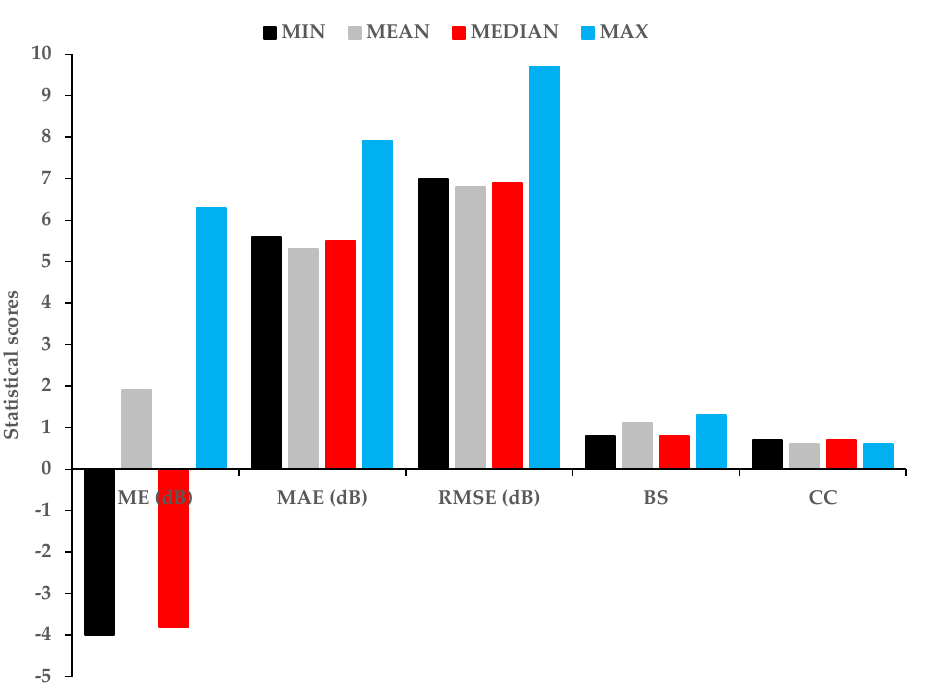
Figure 12. Bar graph showing the performance of corrected reflectivity with the MMLm using different optimal correction coefficient a for the stratiform rainfall case.